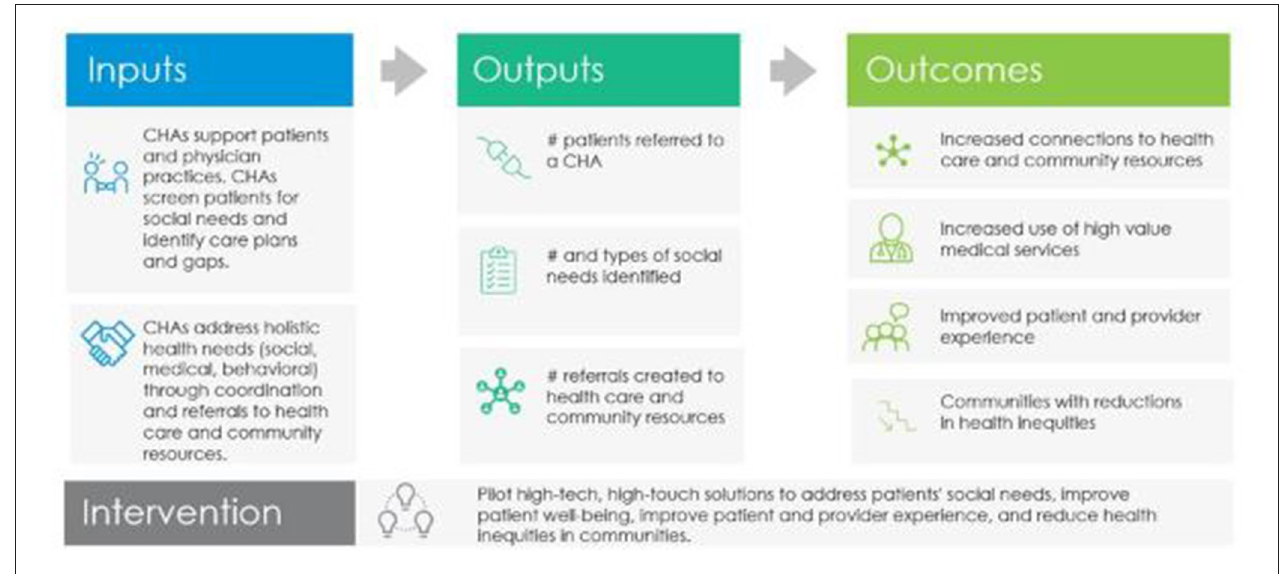
FIGURE 1 | Logic model for blue shield’s CHA